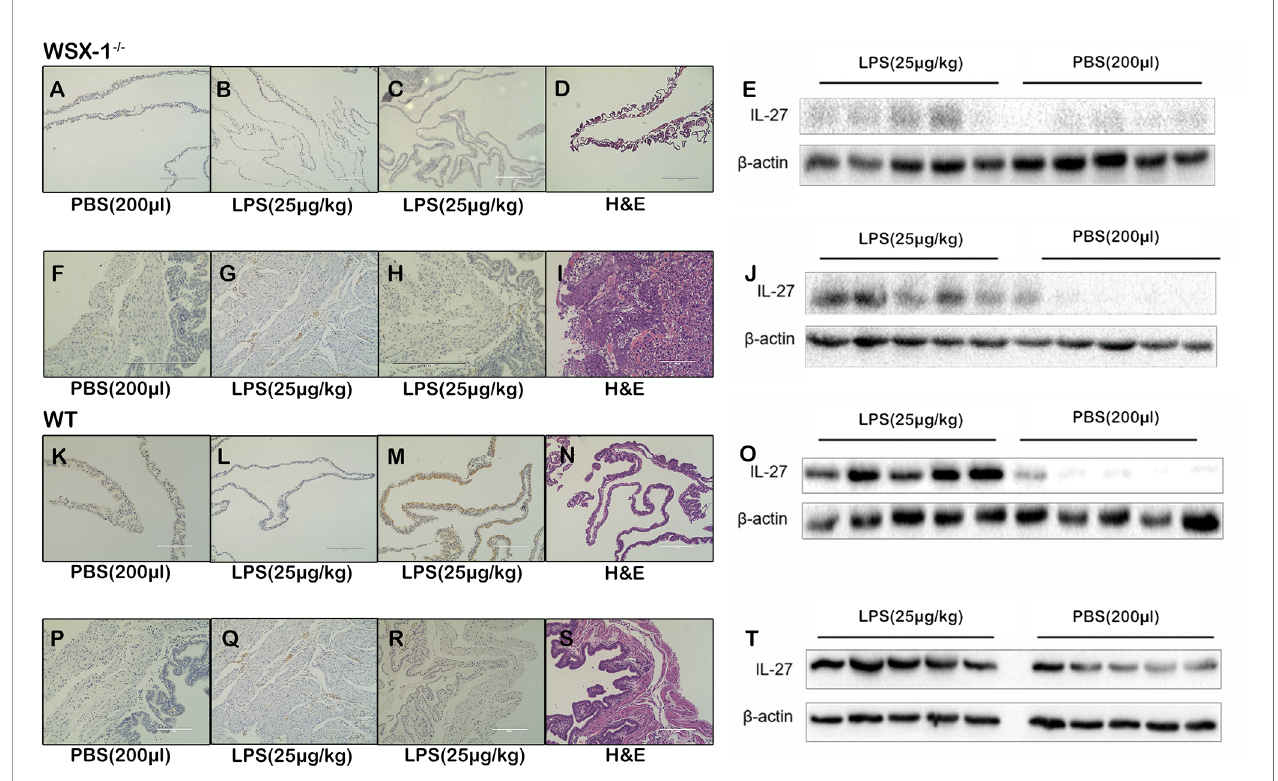
FIGURE 2 | The role of IL-27 at the maternal-fetal interface in the WSX-1 -/- and wild-type mouse model of PTL. Immunohistochemical analysis of IL-27 protein expression and localization in (A, C) fetal-membranes and (F, H) uterus from WSX-1 -/- mice treated for 6 h with PBS or with LPS. Immunohistochemical analysis of IL-27 protein expression and localization in (K, M) fetal-membranes and (P, R) uterus from wild-type mice treated for 6 h with PBS or with LPS. H&E ensure the structure (D, I, N, S) . The others were controls for antibody speci fi city (B, G, L, Q) . Western blot analysis of IL-27 protein levels in (E) fetal-membranes and (J) uterus from WSX-1 -/- mice treated for 6 h with PBS or with LPS (25 µg/kg). Western blot analysis of IL-27 protein levels in (O) fetal-membranes and (T) uterus from WT mice treated for 6 h with PBS or with LPS (25 µg/kg). (n = 6